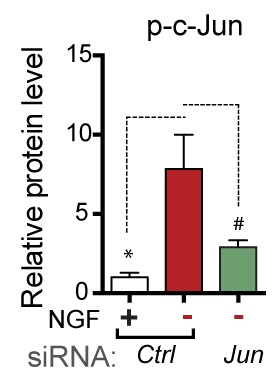
Quantification of p-c-Jun immunoblots presented in Figure 4e (NGF-withdrawal in siRNA-transfected primary DRG cultures, n = 4–5/condition, three experiments).# corresponds to p=0.19.